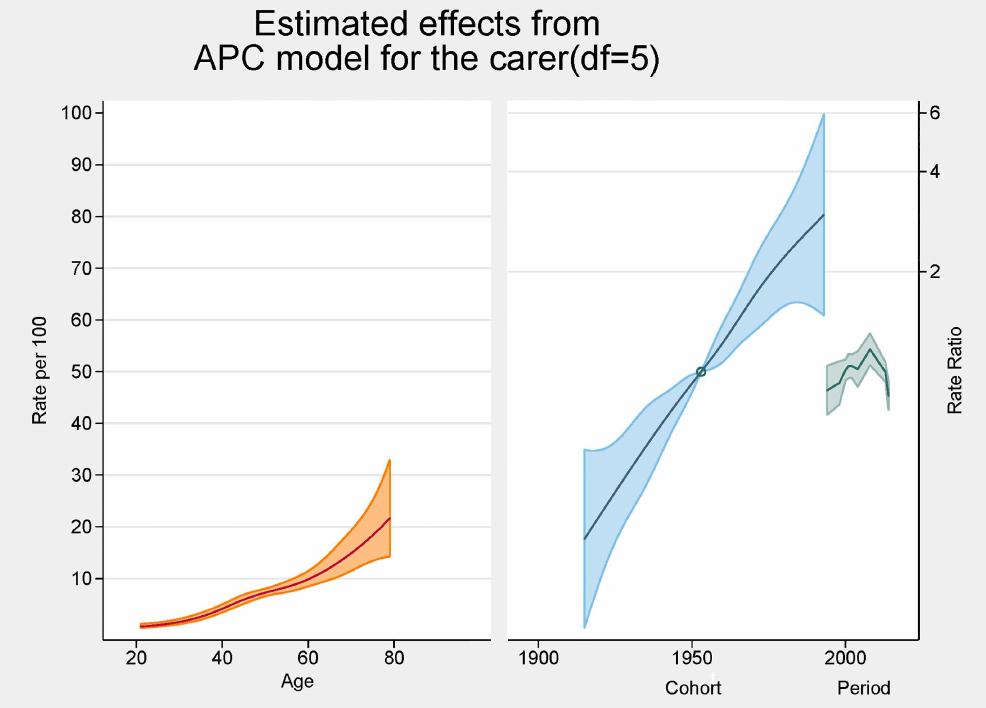
Fig 2. APC analysis of informalcaregivingin SouthAustraliashown as linegraphsrepresenting rates(%) and rate ratios,with95% confidence intervals.